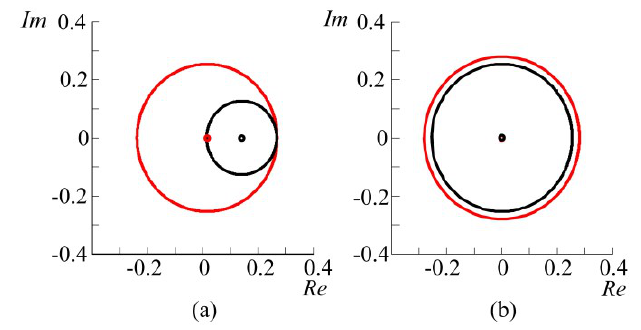
Fig. 9: Real System Transformation (a) Eccentric Plane e (b) Concentric Plane.